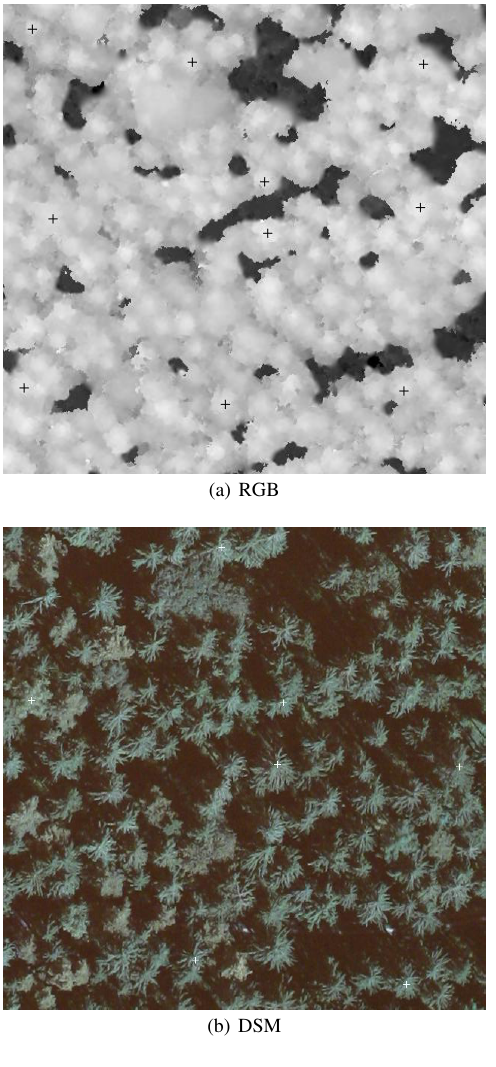
Figure 2. Illustration of the transformation of manually marked point locations from the DSM to the